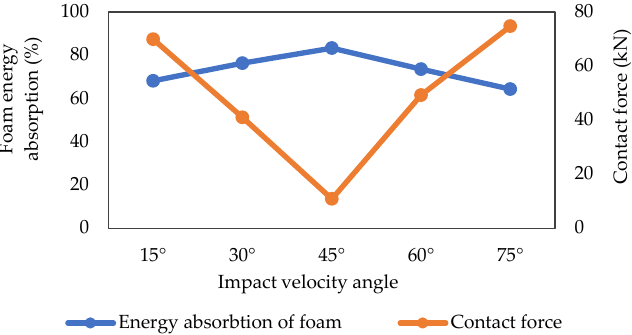
Figure 16. Energy absorption and contact force from simulation at 27 kph in case II.